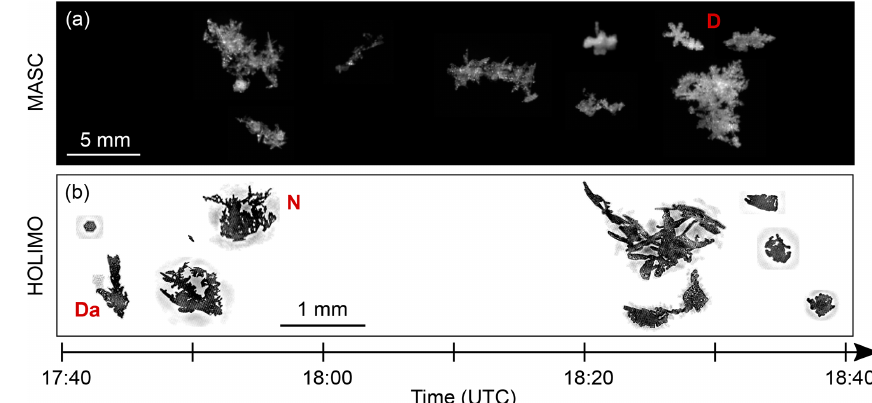
Figure 11. Photographs of ice crystals and snow particles taken with the MASC (a) and HOLIMO (b) . No observations of HOLIMO were available between 17:50 and 18:20UTC. Please note the different size scale of the particles observed by the MASC and HOLIMO. Examples of crystal types observed by the MASC and HOLIMO are highlighted in red: dendrites (D), dendritic arm (Da), ice particles with needle-like structures (N). The hydrometeors measured by the disdrometer at Wolfgang were primarily in the size range between 0.5 and 1.5mm (not